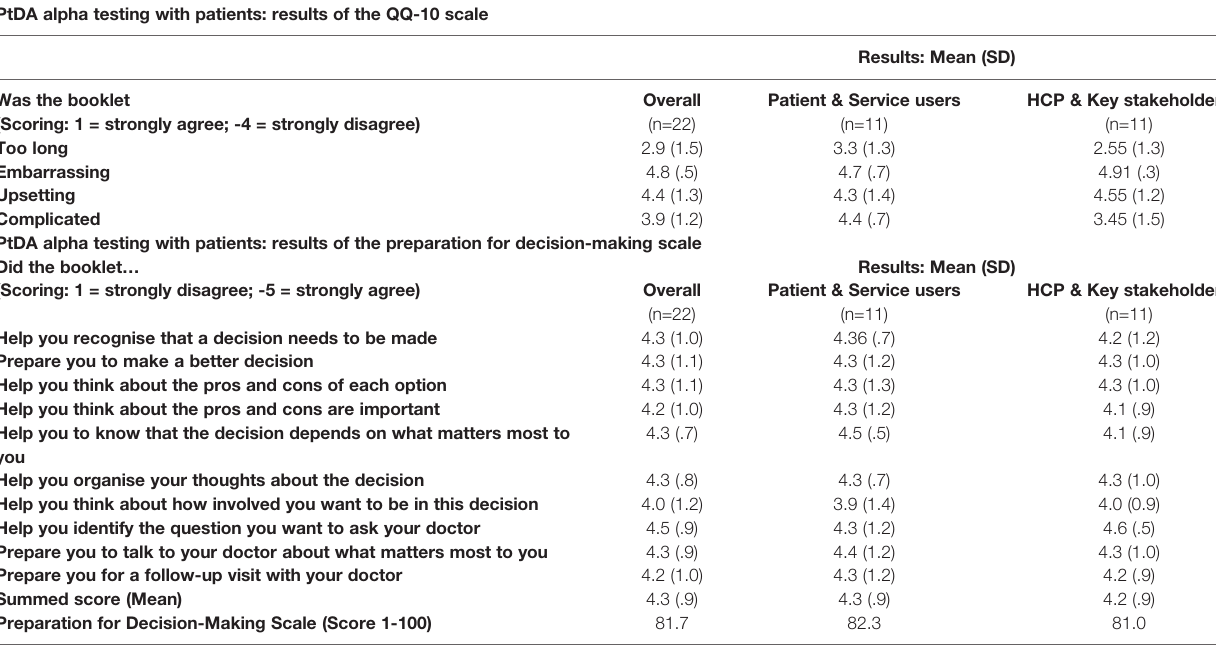
TABLE 3 | Results of the QQ-10 scale and the preparation for decision-making scale during alpha testing. PtDA alpha testing with patients: results of the QQ-10 scale